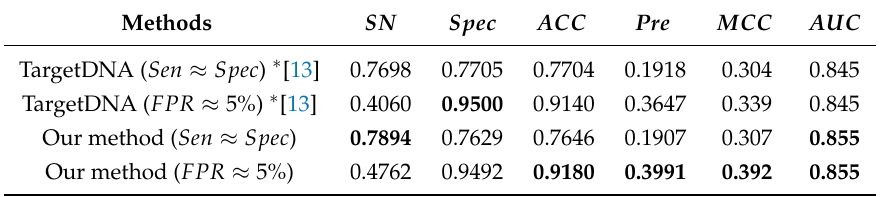
Table 3. Comparison with the TargetDNA on PDNA-543 dataset by ten-fold cross-validation.